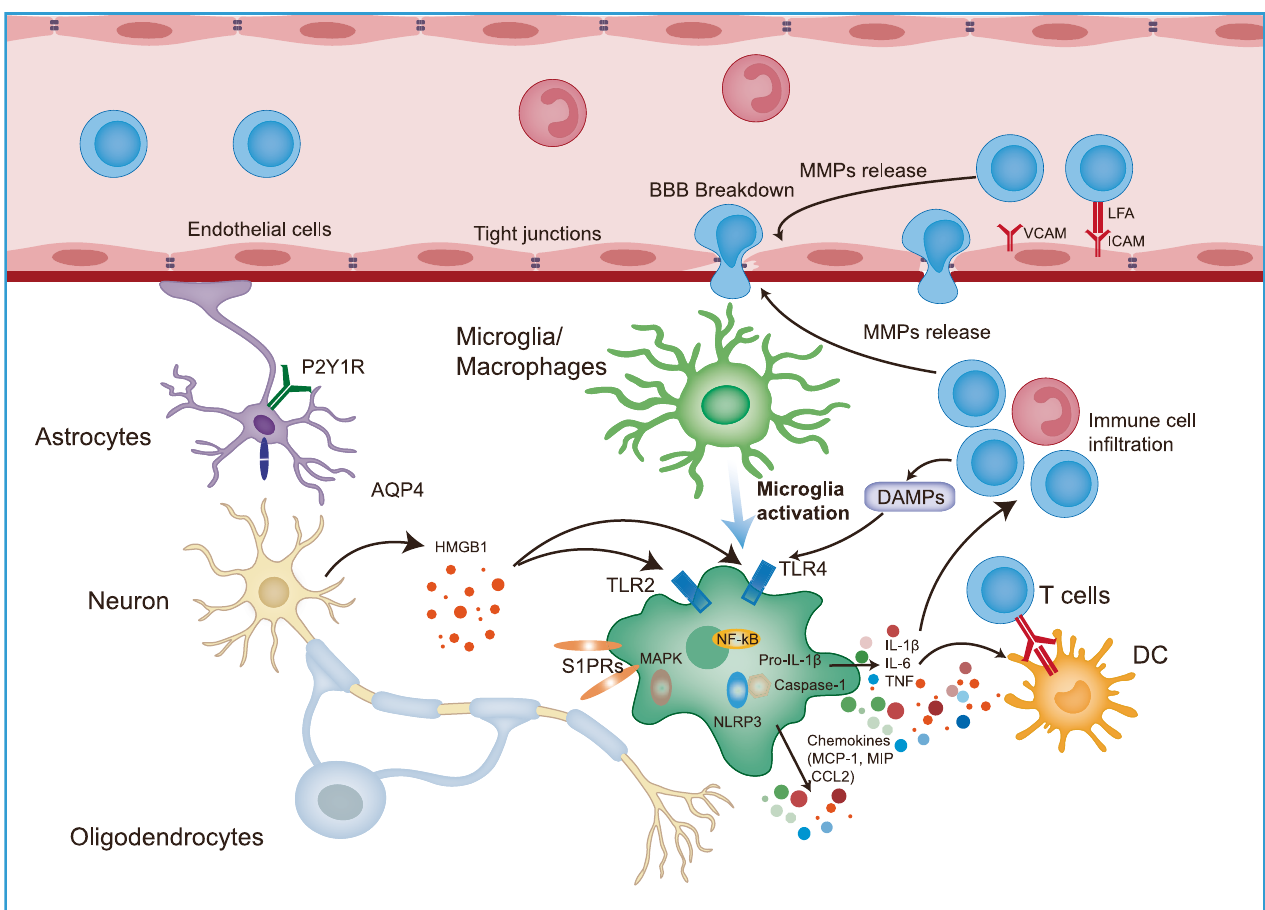
Fig. 6 Neuroin fl ammation, BBB breakdown and related signaling pathways involved in ischemic stroke. DAMPs Damage-associated molecular patterns; AQP4 Aquaporin 4; HMGB1 High-mobility group box protein 1, TLR2 Toll-like receptor 2; TLR4 Toll-like receptor 4; MAPK Mitogen- activated protein kinase; NF-kB Necrosis factor-kB; NLRP3 Nod-like receptor protein-3; MCP-1 monocyte chemoattractant protein-1; MIP Macrophage in fl ammatory protein; CCL2 Chemokine-chemokine ligand 2; IL-1 β Interleukin-1 β ; IL-6 Interleukin-6; TNF Tumor necrosis factor; BBB Blood-brain barrier; S1PRs Sphingosine-1-phosphate receptor; VCAM Vascular cell adhesion molecule; LFA Lymphocyte Function- associated Antigen; ICAM Intercellular cell adhesion molecule; DC Dendritic cells; MMP Matrix